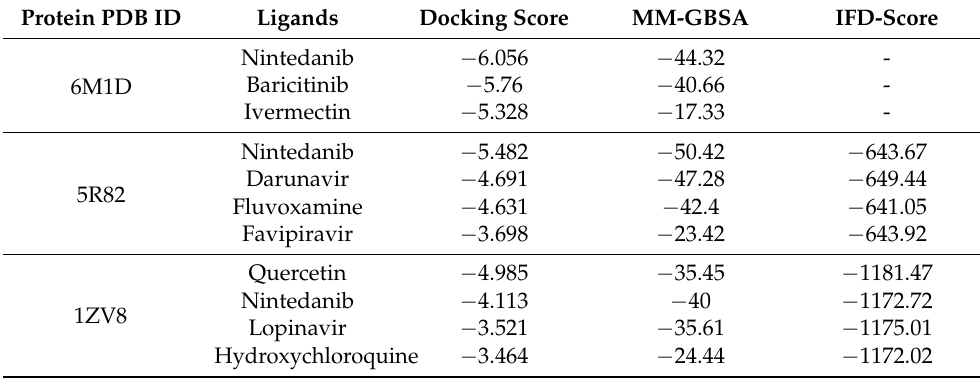
Table 3. Docking score, MM-GBSA and